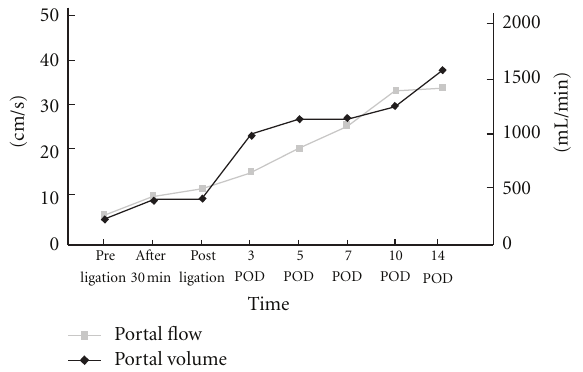
Figure 3: Alteration of portal flow speed and volume. The portal flow speed and volume increased for 14 days